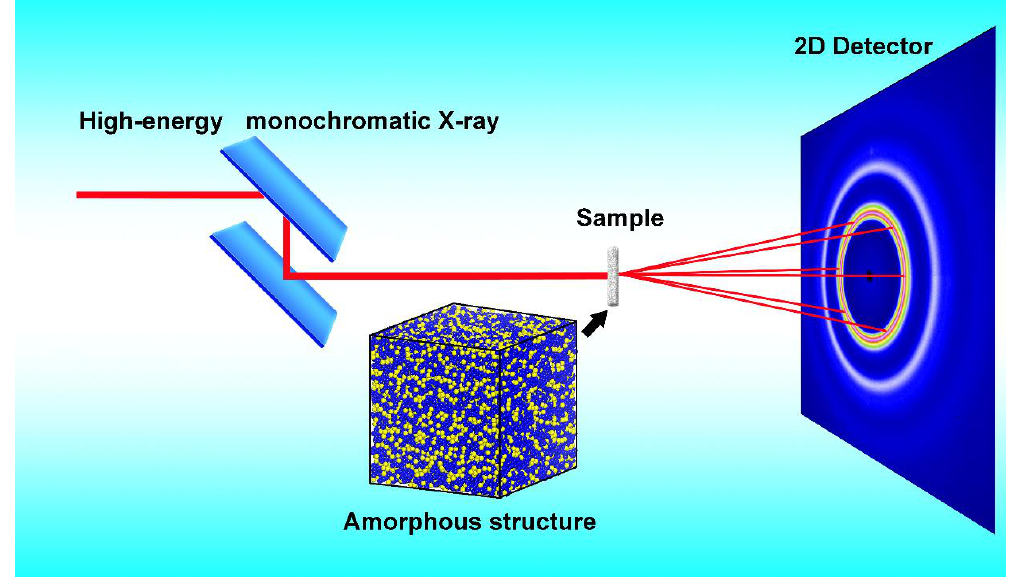
Figure 1. The setup layout of synchrotron radiation-based high-energy (about 100 keV) X-ray diffraction measuring amorphous alloys. By combining XRD and EXAFS data